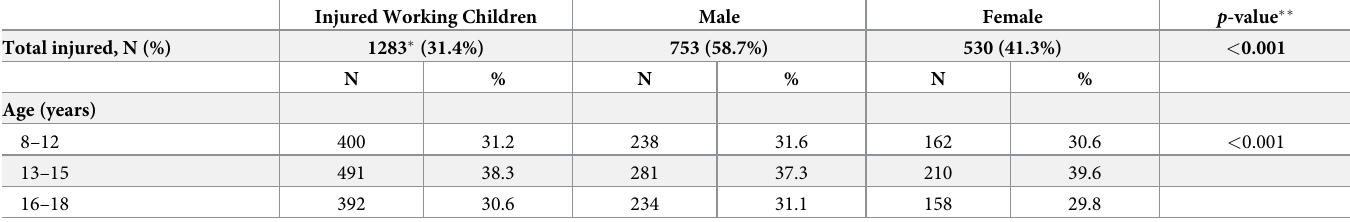
Table 2. Syrian refugee working children (8–18 years) reporting work-related injury across age groups in the Bekaa Valley, Lebanon, 2017 (N = 4090). Injured Working Children Total injured, N